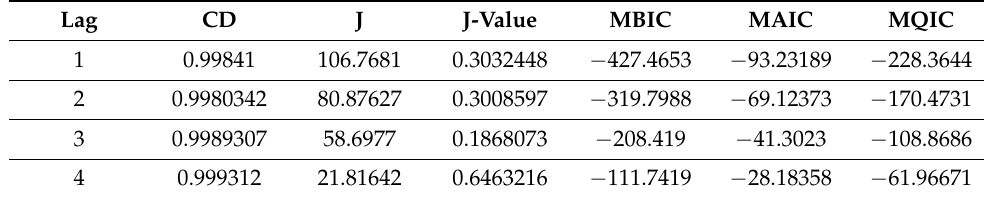
Table 4. Moment and Model Selection Criteria (MMSC) for GDP Shock.